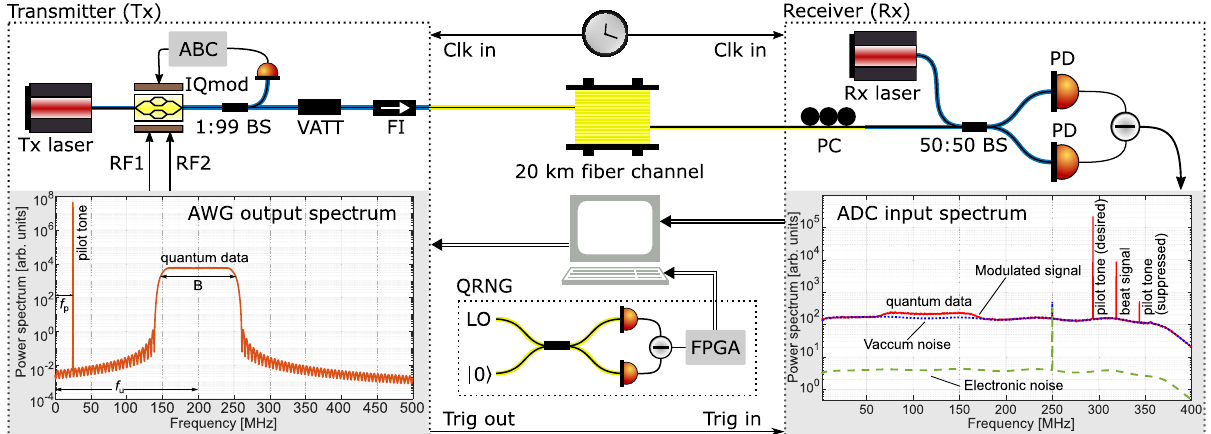
Fig. 2 | Schematic of the experiment. The transmitter (Tx) and receiver (Rx) were built from polarization maintaining fi ber components. The transmitter comprised a 1550nm continuous-wave laser (Tx laser), an in-phase and quad- rature electro-optic modulator (IQmod) with automatic bias controller (ABC) for carrier suppression and single sideband modulation, and a variable attenuator (VATT) and Faraday isolator (FI). An arbitrary waveform generator (AWG) with 16 bit resolution and sampling rate of 1 GSps supplied waveforms RF1 and RF2 for driving IQmod. A quantum random number generator (QRNG) delivered Gaussian-distributed symbols for discrete Gaussian modulation of